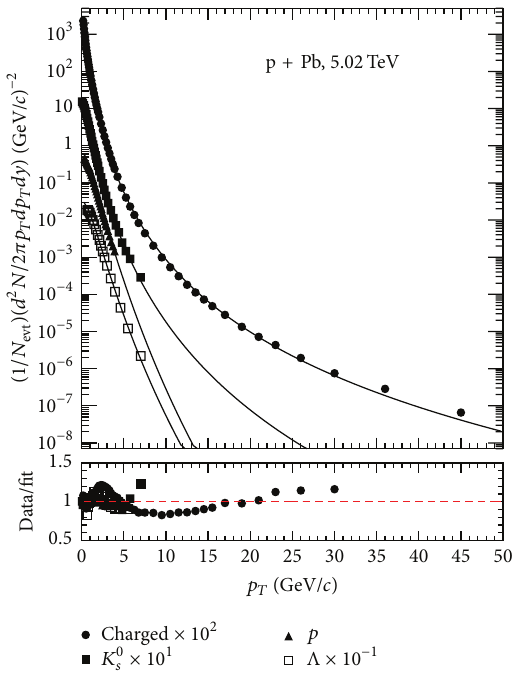
Figure 2: The data are from [34, 43] for p + Pb at √𝑠 𝑁𝑁 = 5 . 02 TeV. The curves are the analytical results with Tsallis distribution Equa- tion (10). The corresponding fitting parameters and 𝜒 2 /ndf are given in Table 1. For a better visualization both the data and the analytical curves have been scaled by a constant as indicated. The ratios of data/fit are shown at the bottom.